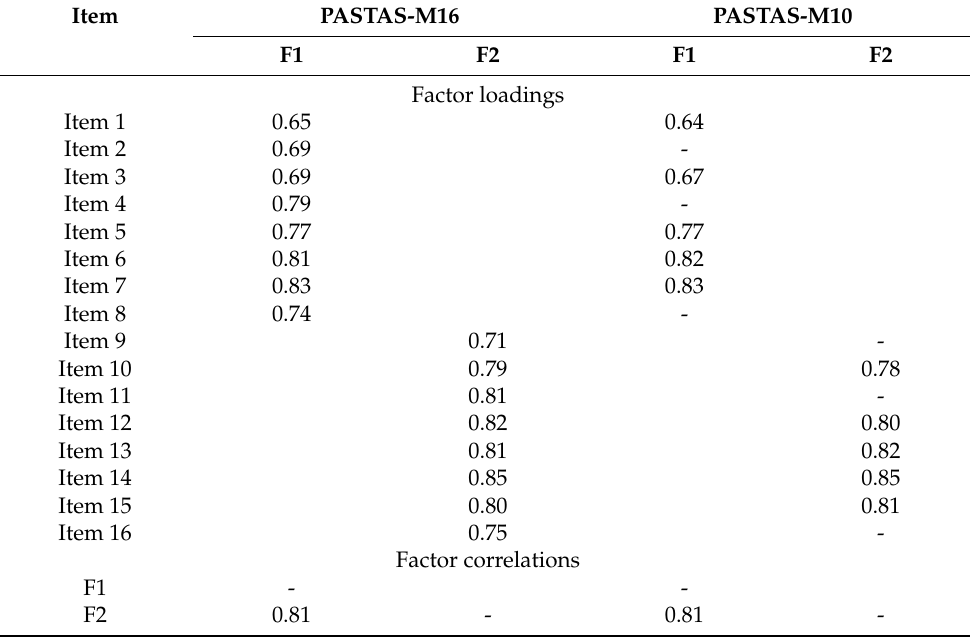
Table 4. Standardized solutions of the confirmatory factor analysis for PASTAS-M16 and PASTAS-M10 models.